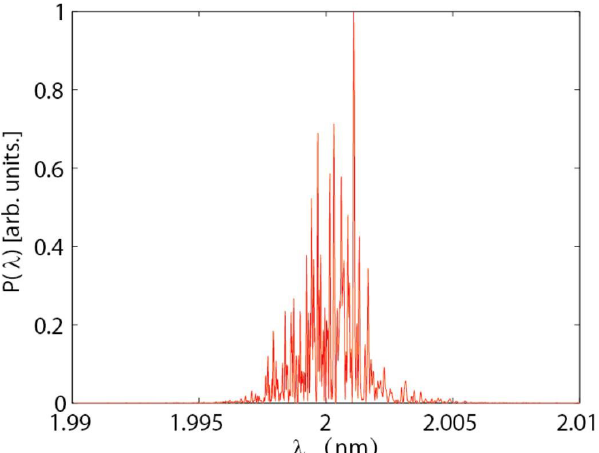
Figure 2. Typical SASE spectrum, in this case from the simulations of an experiment at λ = 2 nm (from